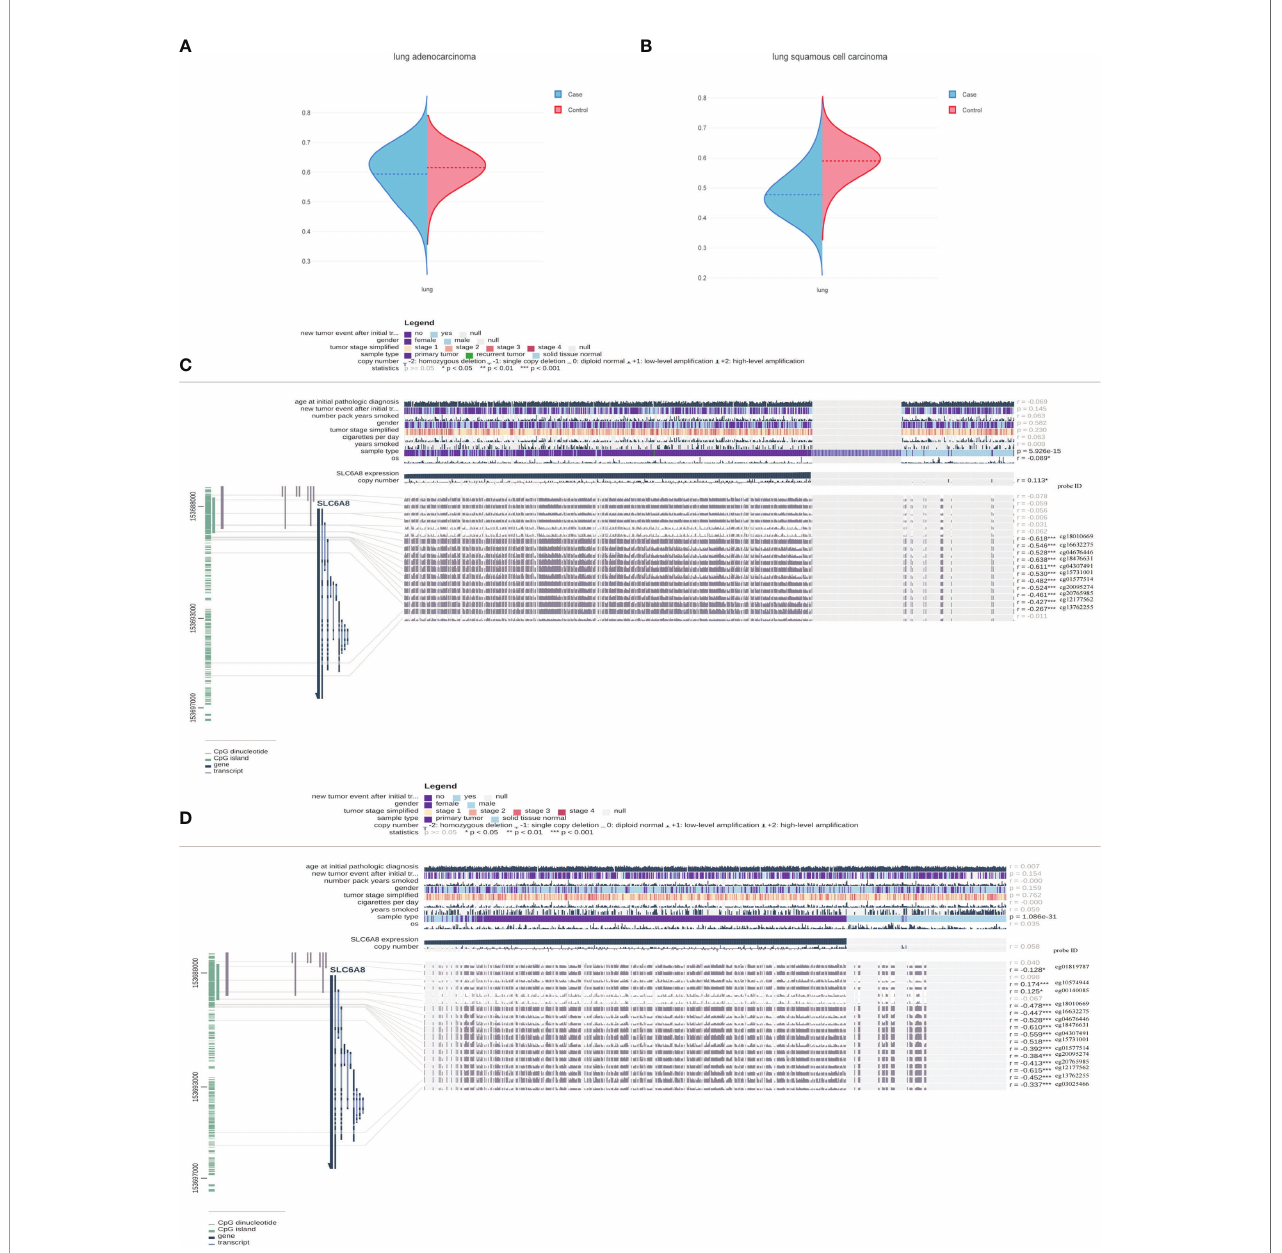
FIGURE 5 | Methylation sites associated with SLC6A8 expression in NSCLC Methylation levels associated with SLC6A8 expression in LUAD (A) and LUSC (B) compared to normal tissues. Methylation regulatory sites associated with SLC6A8 expression in LUAD (C) and LUSC (D) . (r<-0.2; *P-value < 0.05; **P-value < 0.01; ***P-value <